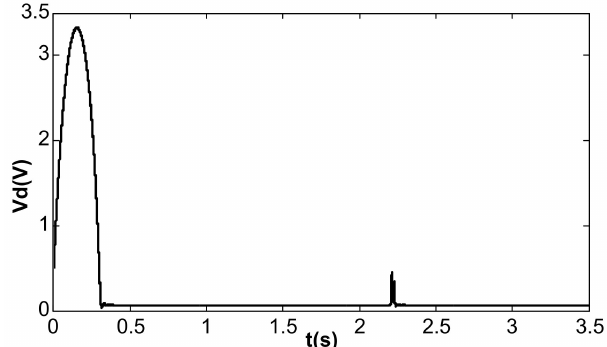
Figure 16. DC driving voltage under double closed loop ( k I = 100, k II = 2).